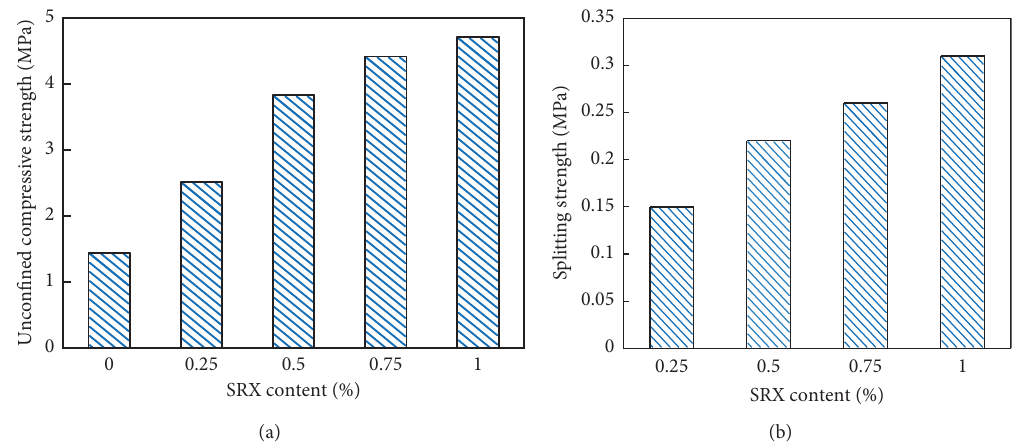
Figure 13: Change law of mechanical strength with SRX content. (a) Unconfined compressive strength. (b) Splitting strength.